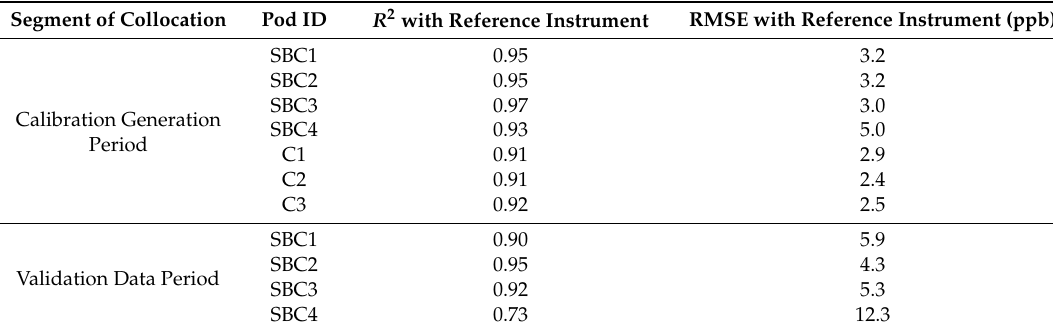
Table 2. Sensor Calibration and Validation Collocation